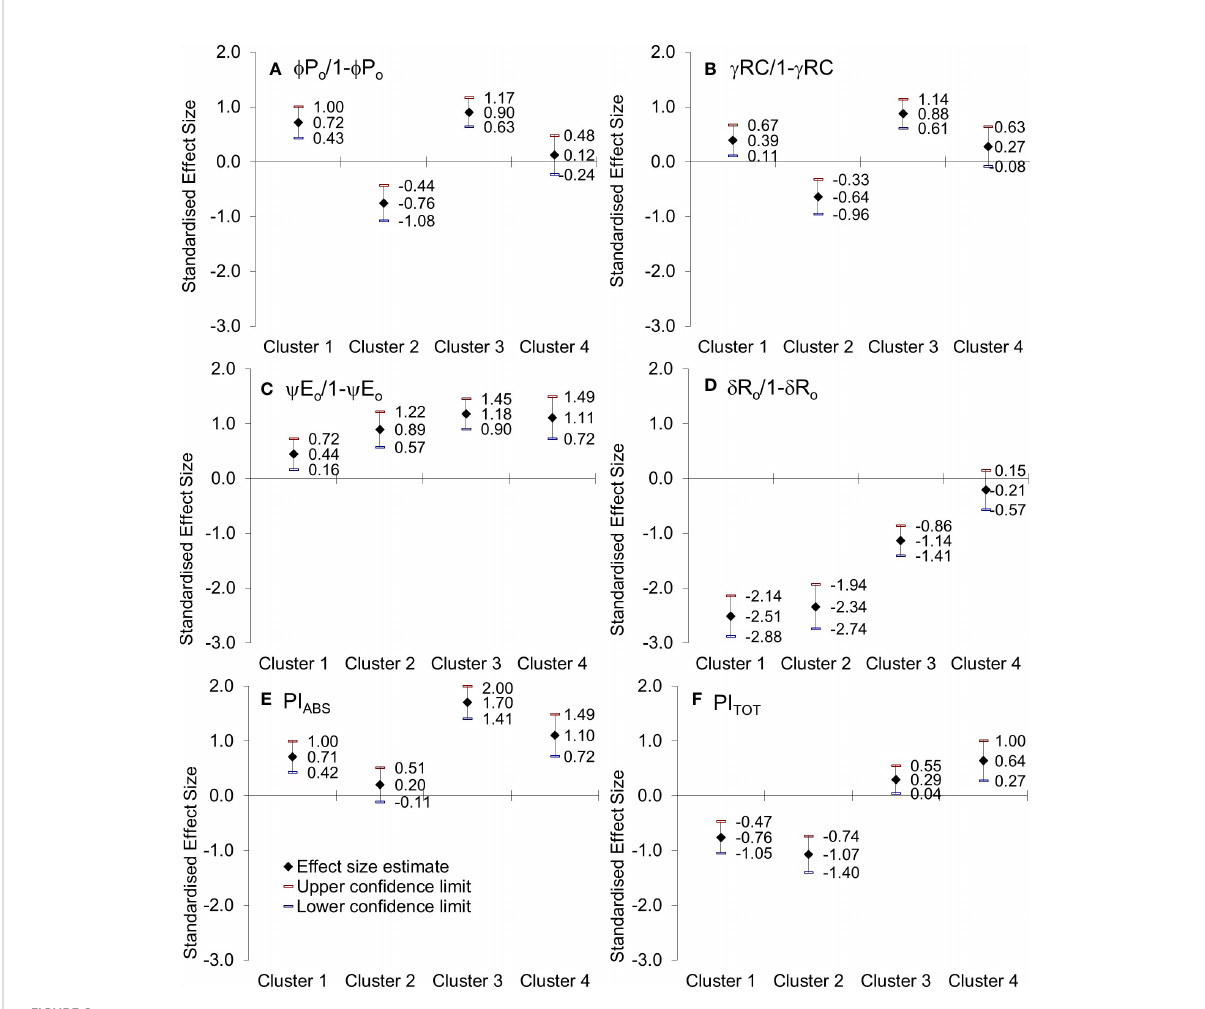
FIGURE 8 Hedges bias-corrected effect size (with con fi dence interval) of PEG-induced drought on (A) the ef fi ciency of the water-splitting complex, (B) the density of active reaction centers at the donor side of PSII, (C) the ability to maintain an electron chain between two photosystems, and (D) reduction of end electron acceptors ( j P0/1- j P0, g RC/1- g RC, y E 0 /1- y E 0 , d R o /1- d R o )), (E) performance index on absorption basis (PI ABS ) and (F) performance index (potential) for energy conservation from exciton to the reduction of PSI end acceptors (PI TOT ) in four obtained Clusters of winter wheat